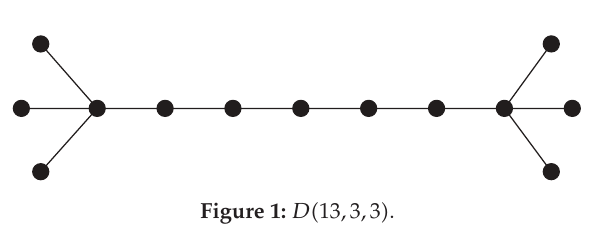
Figure 1: D (cid:2) 13 , 3 , 3 (cid:3)